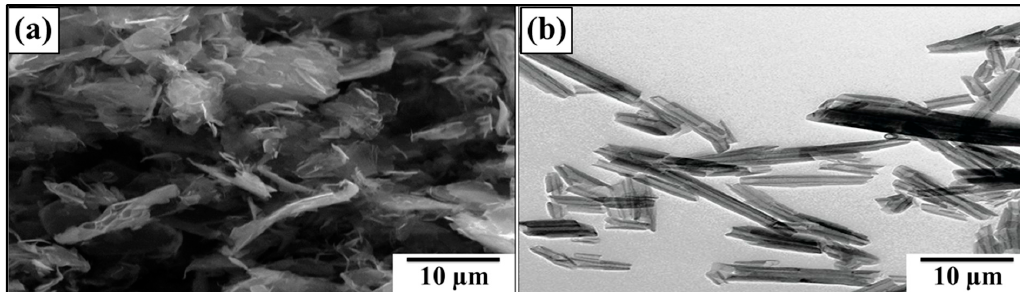
Figure 2. SEM images: ( a ) MLG; ( b ) nanoclay. Figure 3. SEM images: ( a ) MLG; ( b ) nanoclay. Polymers 2016 , 8 , 239